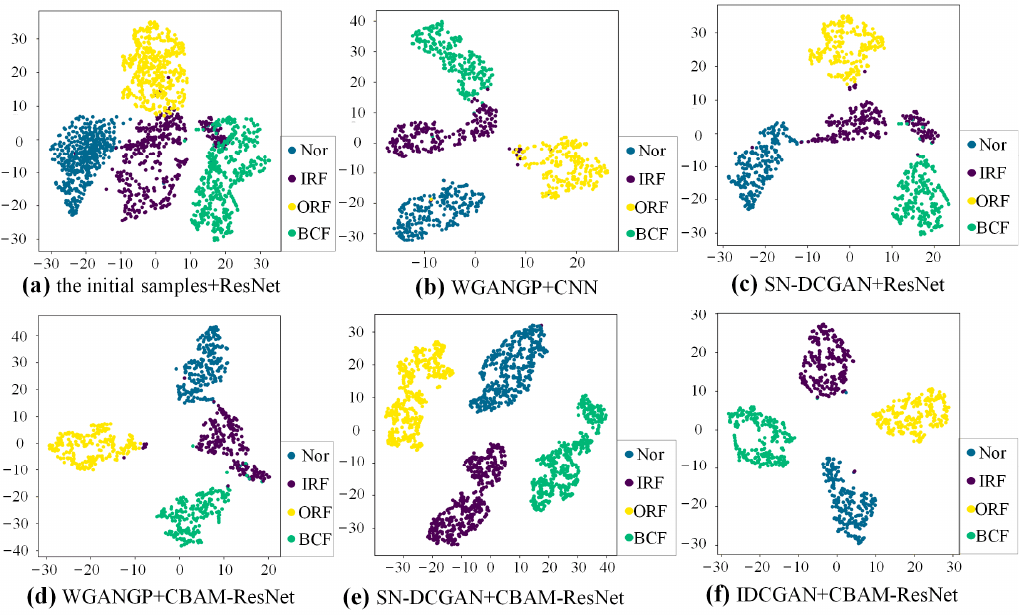
Figure 13. t-SNE visualization with different data augmentation methods and